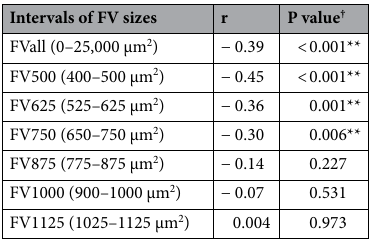
Table 3. The correlation between choroid vascular hyperpermeability and flow void. FV choriocapillaris flow void. † Spearman’s rank correlation coefficient. **P < 0.01.